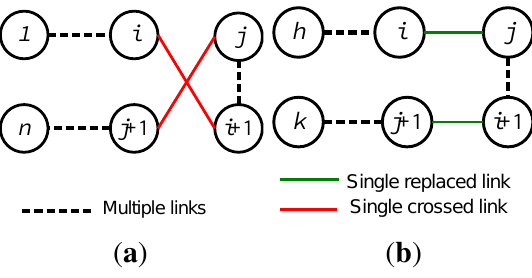
Figure 8. Link exchange. Crossed links are replaced by new